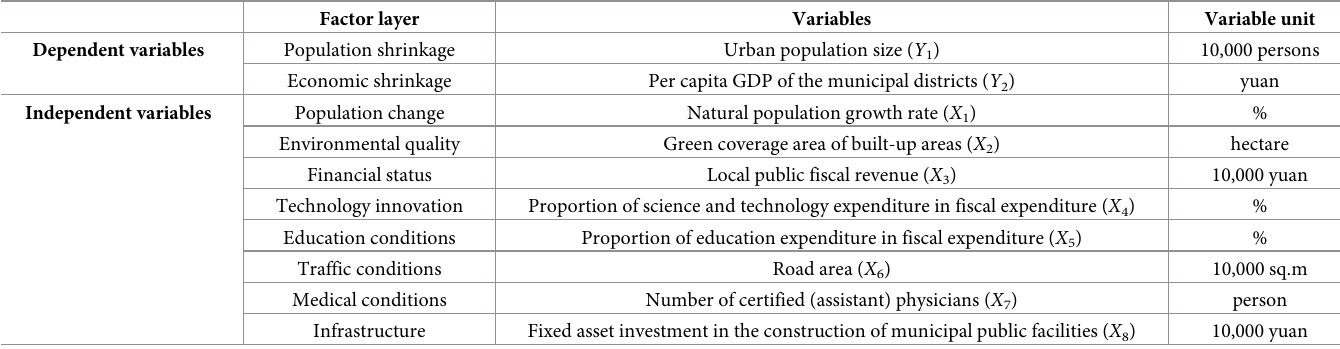
Table 2. The indicator system of the panel regression model of urban shrinkage in the Yellow River